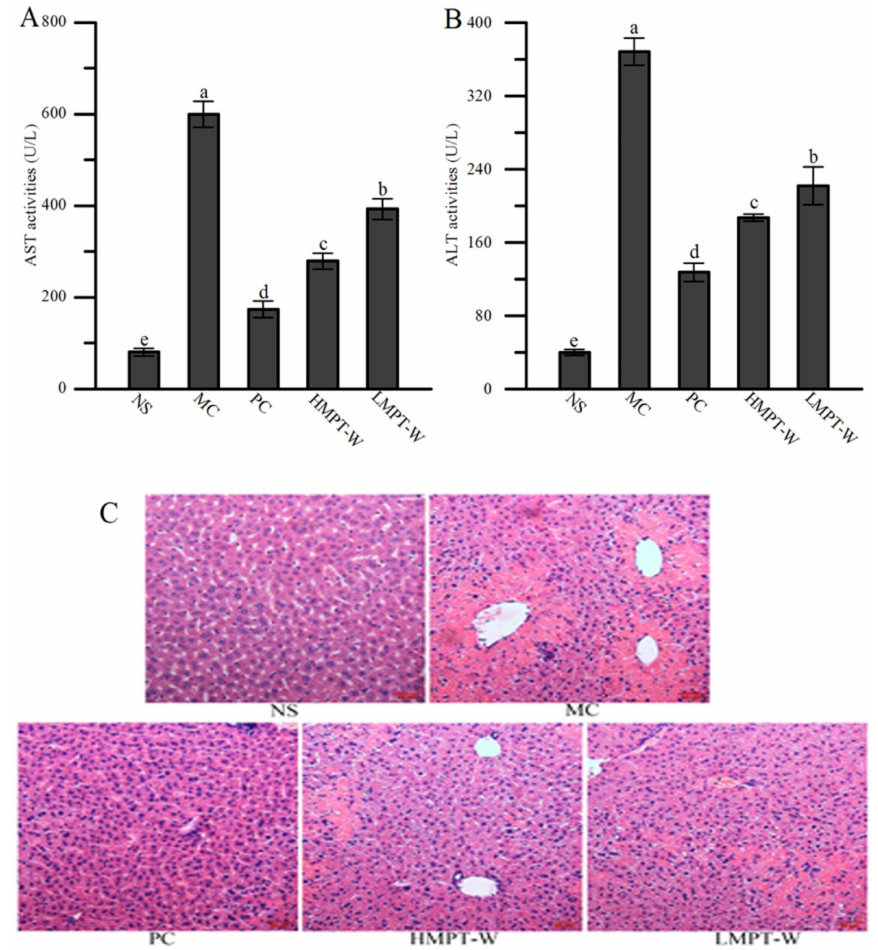
Figure 3. E ff ect of MPT-W on liver injury in CCl 4 -induced chronic liver injury mice. ( A ) aspartate aminotransferase (AST) and ( B ) alanine aminotransferase (ALT) in serum; ( C ) Histopathological images of H&E stained liver sections from the mice of NS, MC, PC, HMPT-W, and LMPT-W groups, magnification 200 × . The values are reported as means ± SD. Bars with di ff erent letters (a, b, c, d, e) are significantly di ff erent ( p < 0.05). NS: normal saline, MC: model control, PC: positive control, HMPT-W: 400 mg / kg MPT-W, LMPT-W: 200 mg / kg MPT-W, AST: aspartate aminotransferase, ALT: alanine